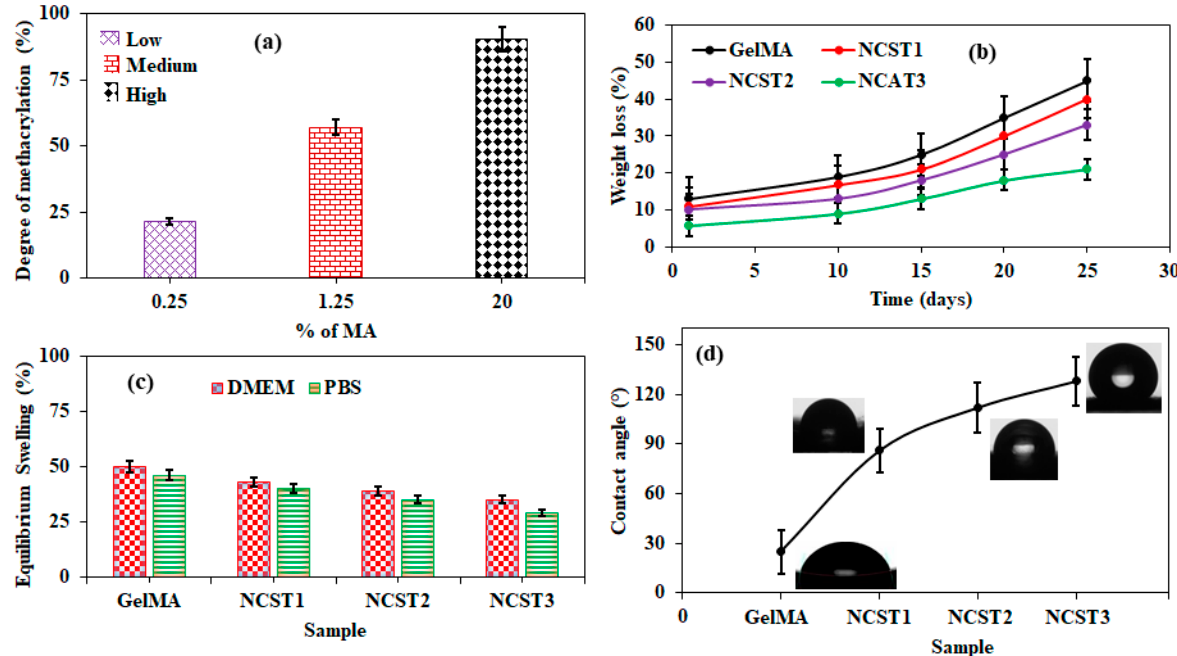
Figure 1. ( a ) Degree of methacrylation as determined by TNBS study; three-volume percentages (0.25%, 1.25%, and 20%) of MA were explored to scrutinize the degree of methacrylation of GelMA. ( b ) Degradation, ( c ) swelling, and ( d ) water contact angle of pristine GelMA and NCST hydrogels under 600 s UV exposure.